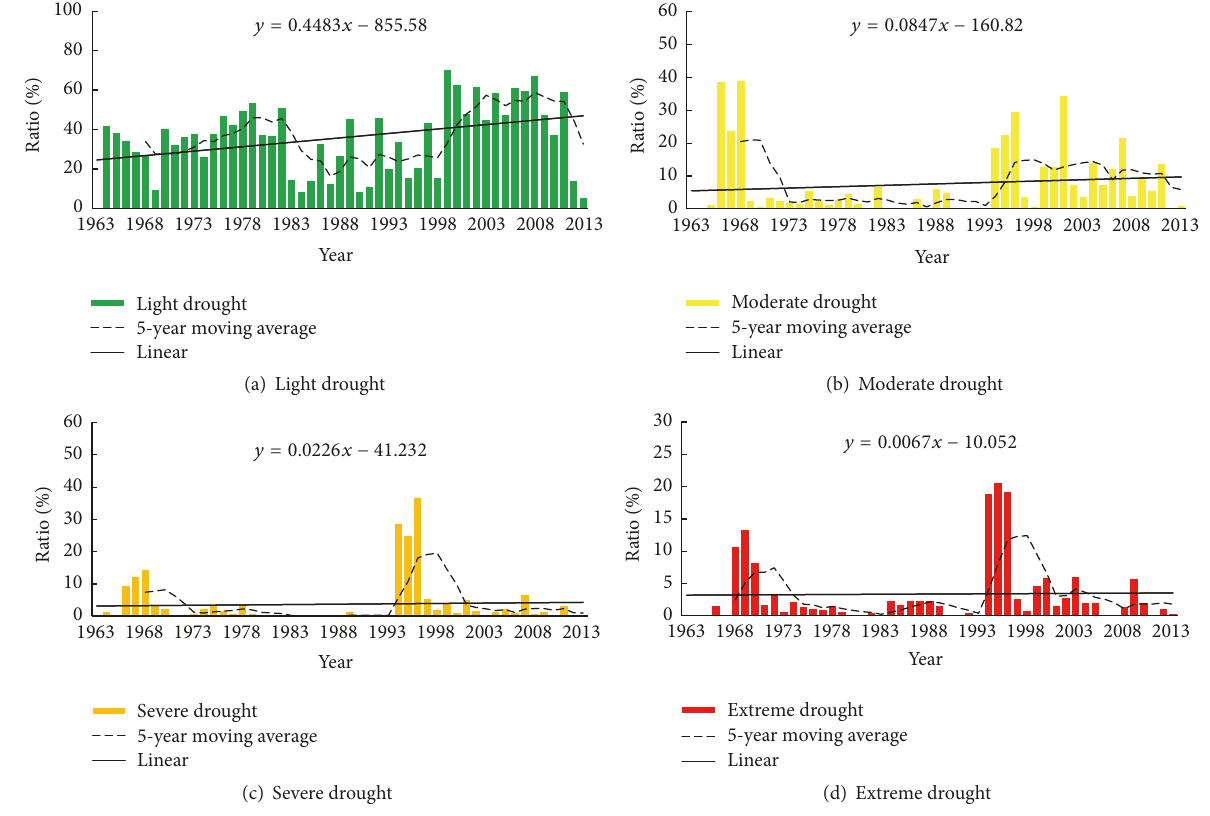
Figure 5: The interannual variability of drought area in four